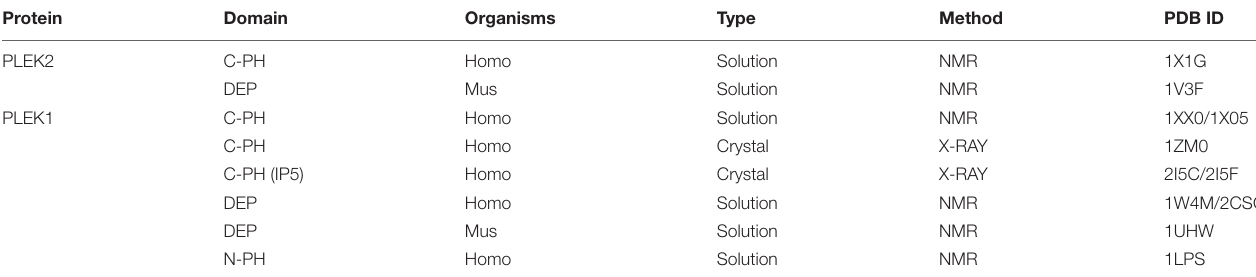
TABLE 1 | Three-dimensional protein structures of PLEK2 and PLEK1.